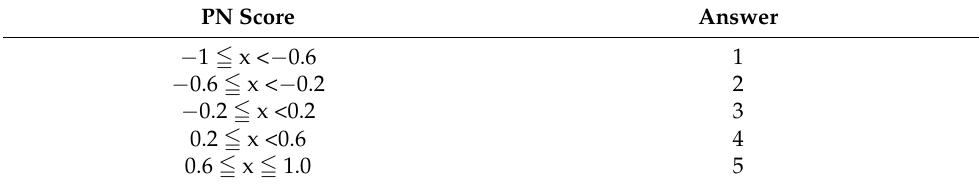
Figure 4. Overall flowchart of QOL estimation from utterances. Table 2. Correspondence between PN score and answer